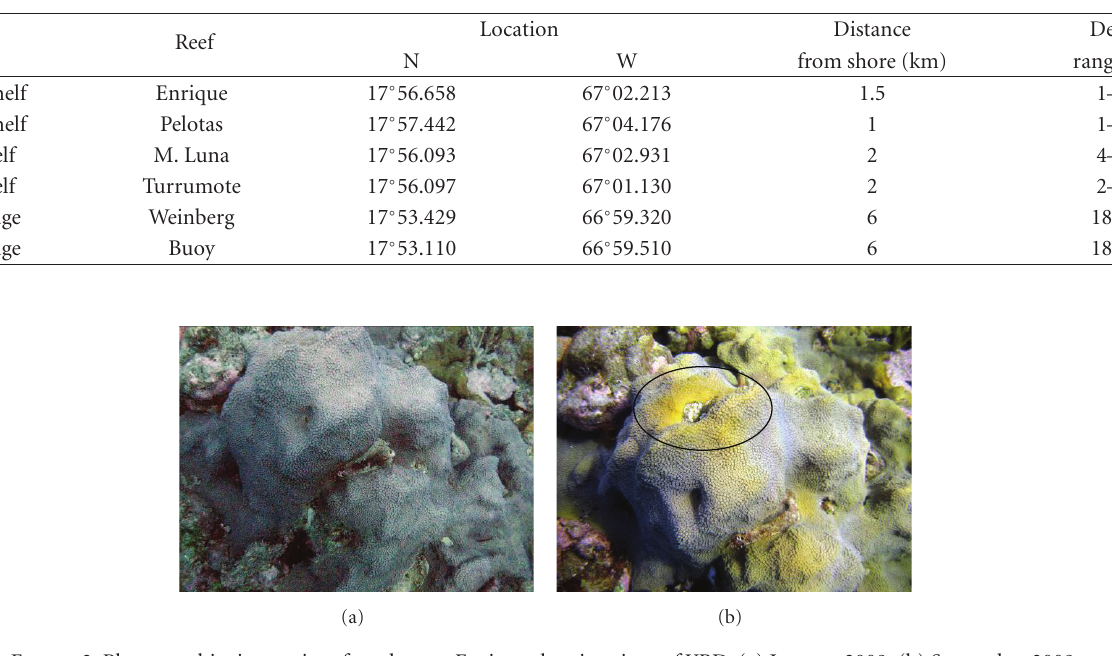
were followed by multiple comparison tests. Statistica 7 software was used to run the